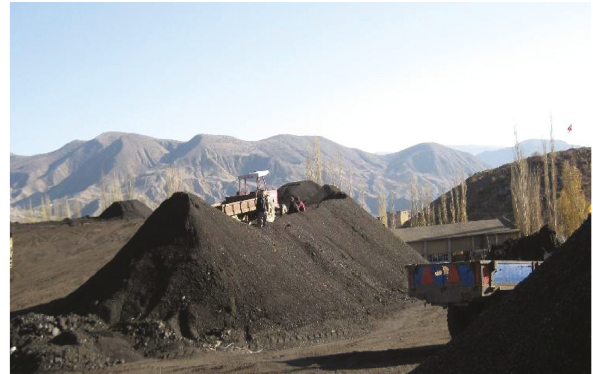
Figure 1: Erzurum/S¸enkaya coals storage area. Table 1: Sample-C1 coal sample point coordinates.